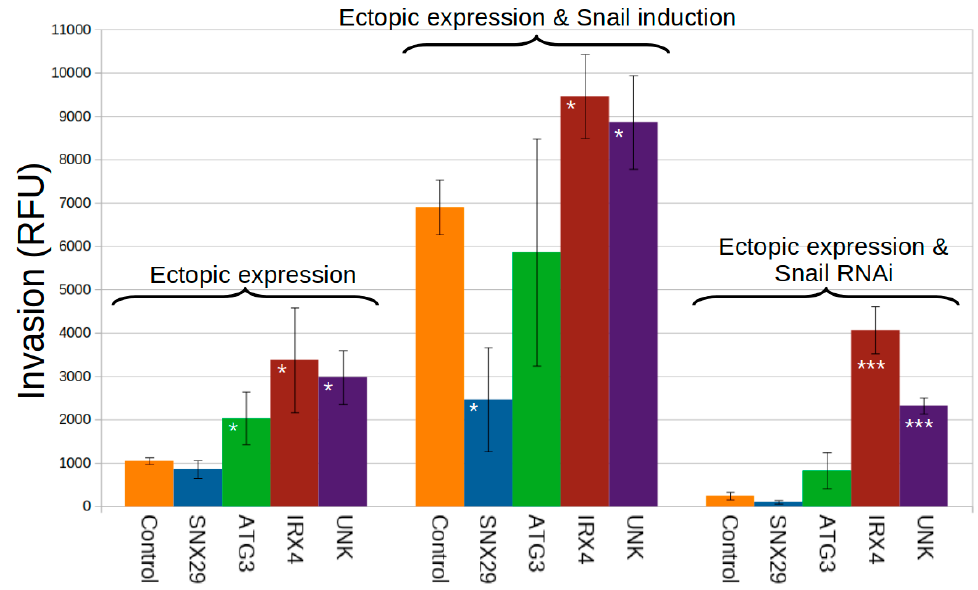
Figure 6. Validation of candidate invasion genes in breast cancer cells. The fluorescence signal from invasive MCF7 cells is shown. Induction of every gene examined significantly changed invasion in least one of three conditions: (a) Ectopic expression; (b) ectopic expression and SNAI1 induction; (c) ectopic expression with shRNA knockdown of SNAI1 . SNX29 (blue) had reduced invasion compared with the SNAI1 induction control (orange); UNK (purple) and IRX4 (dark red) had increased invasion in all three conditions examined; ATG3 (green) had higher invasion at background levels of SNAI1 (without induction or knockdown). Mean values are shown, error bars indicate 95% CI, n = 3; * q < 0.05; *** q < 5.0 × 10 − 4 .